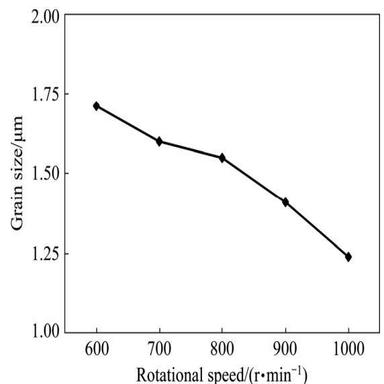
Effect of rotational speed on grain size of composite coating